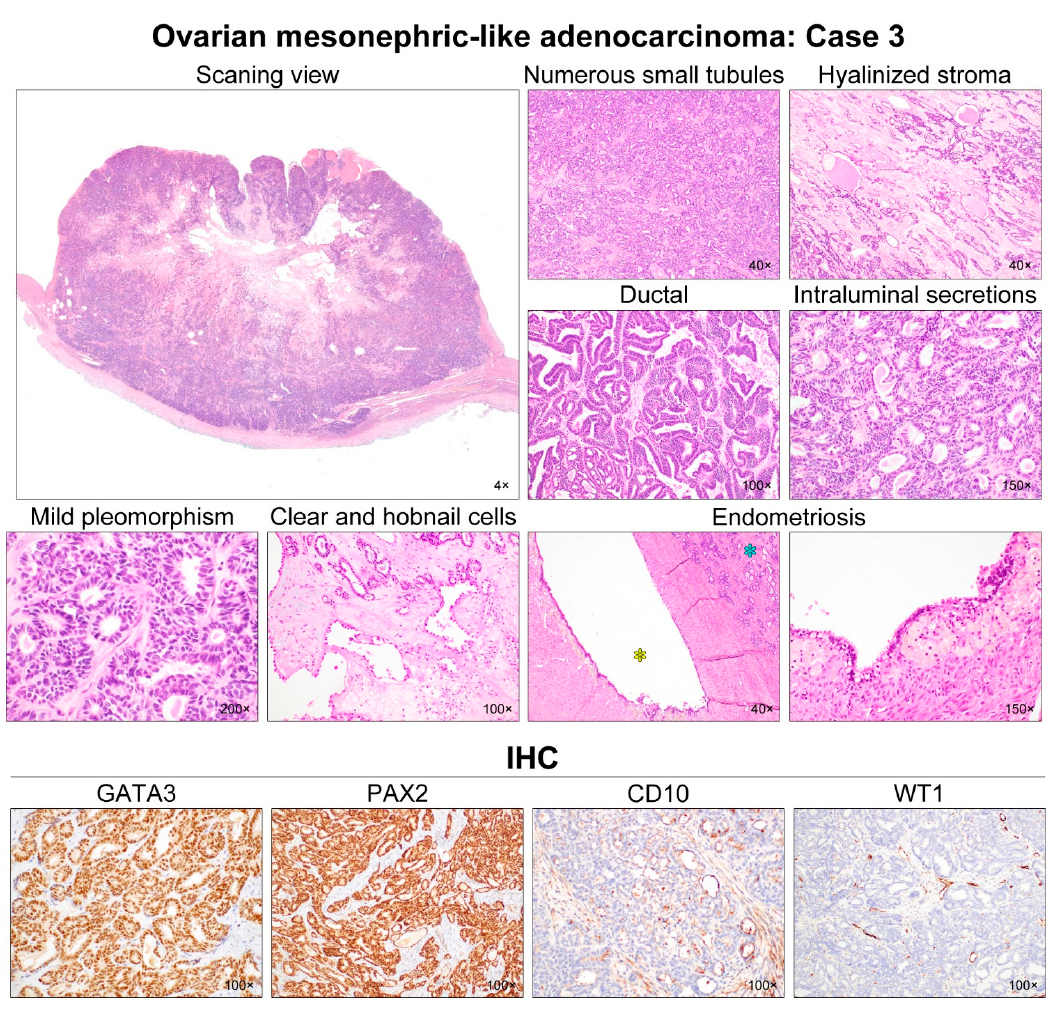
Figure 4. Histological features of ovarian MLA: Case 3. Scanning magnification revealed that the solid component was a hypercellular tumor, with areas of cystic change and degeneration in the central portion. Numerous small tubules were compactly aggregated and merged. The amount of intervening stroma was small, but the central portion had some microscopic areas of stromal degeneration and hyaline fibrosis. An endometrioid-like glandular structure (i.e., ductal growth pattern), accompanied with focal maze-like architecture, comprised approximately one-third of the entire tumor volume. These tubules and endometrioid-like glands were lined by cuboidal and columnar epithelial cells, respectively, and possessed pale or dense eosinophilic intraluminal secretions. Most tumor cell nuclei demonstrated intermediate-grade atypia characterized by mild-to-moderate pleomorphism and hyperchromasia, with rare mitotic figures. In a few foci, dilated glands were lined by a single layer of tumor cells with clear-to-eosinophilic cytoplasm and a hobnail appearance. Their nuclei were similar in size and shape to those of the adjacent tubules. The intervening stroma showed sparse inflammatory infiltrate, and focal myxoid and hyaline degeneration. An endometriotic cyst (yellow asterisk) was observed adjacent to the tumor tissue (blue asterisk). The lining epithelium of the endometriotic cyst underwent extensive tubal metaplasia. The endometrial stroma was filled with hemosiderin-laden macrophages. Immunostaining revealed that the tumor cells were diffusely and strongly positive for GATA3 and PAX2. CD10 expression, along the luminal surface of the tubules and ducts, was characteristic of MLA. Lack of WT1 expression excluded the possibility of serous carcinoma.